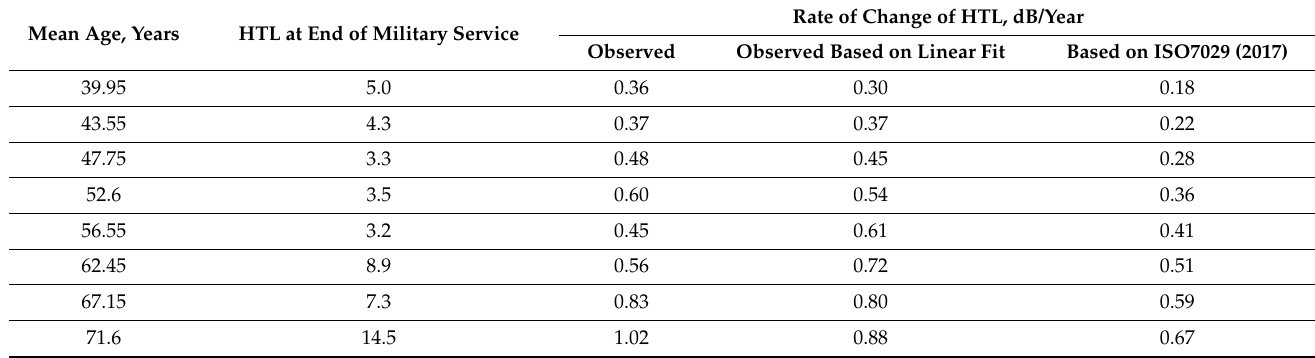
Table 3. As Table 2, but for the right ear at 1